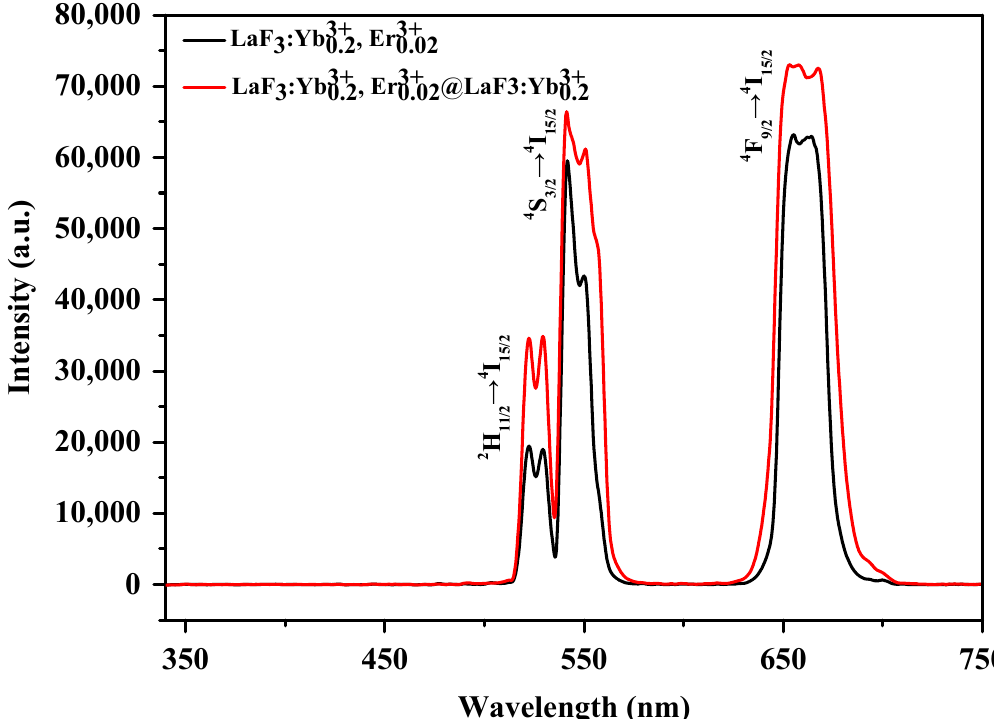
Figure 8. Photoluminescence spectra of LaF 3 :Yb 3 + 0.20 , Er 3 + 0.02 core UCNPs and LaF 3 :Yb 3 + 0.20 , Er 3 + 0.02 @LaF 3 :Yb 3 + 0.20 core / shell UCNPs.